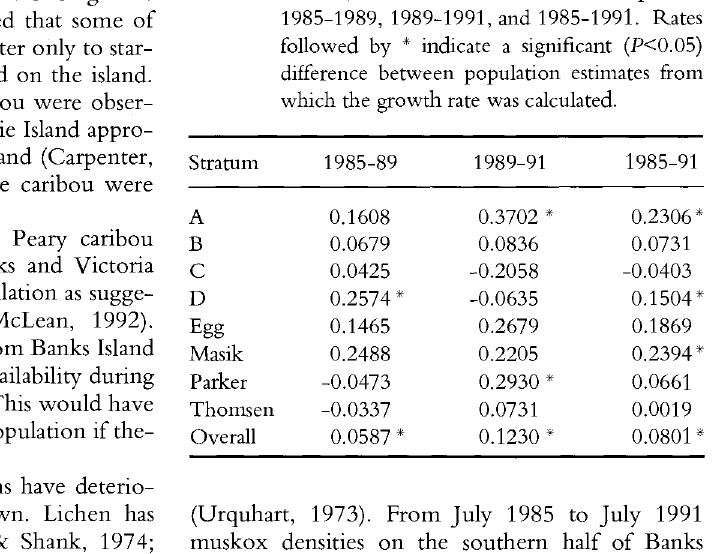
Table 4. The instantaneous rates of growth (r) for each stratum, and the total island for the periods 1985-1989, 1989-1991, and 1985-1991. Rates followed by * indicate a significant